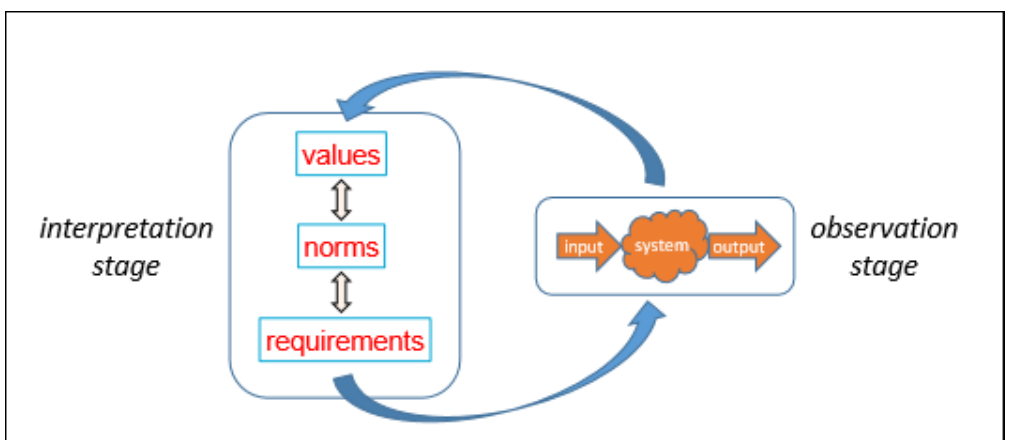
Figure 2. Glass Box framework (as in: Aler Tubella et al.